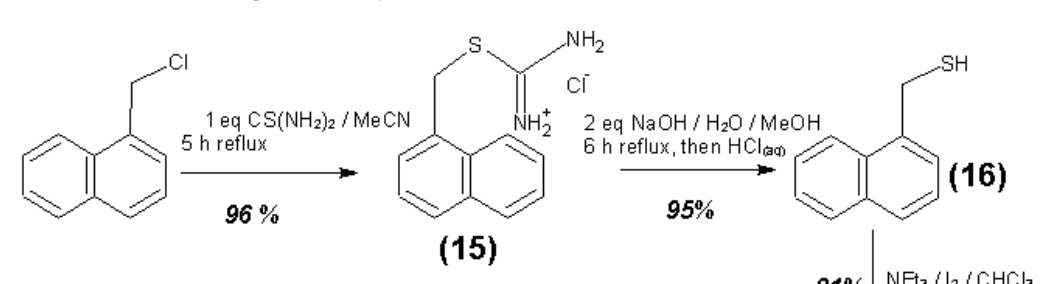
Figure 18. Synthesis steps for substances 15 to 17.